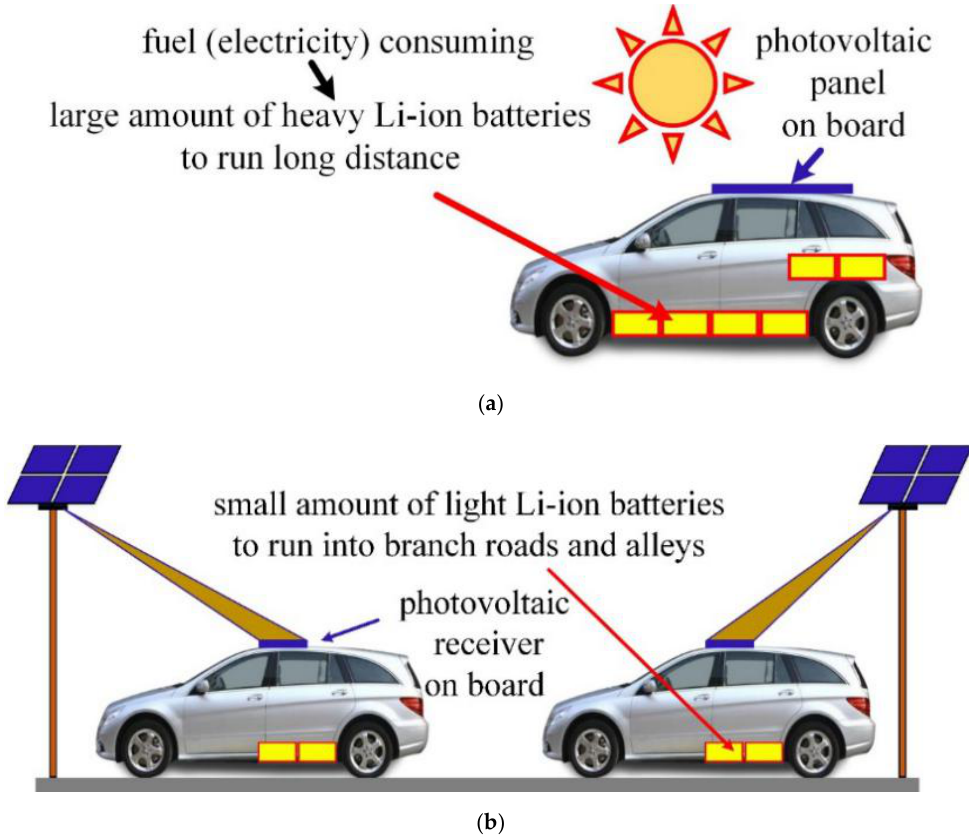
Figure 28. The solar panels on the roof of electric vehicles (EVs) receive laser light from infrastructure along arterial roads; ( a ) sunlight illuminates directly at photovoltaic cells on car roof; ( b ) photovoltaic cells on the car roof illuminated by laser generated from solar-pumped [113].